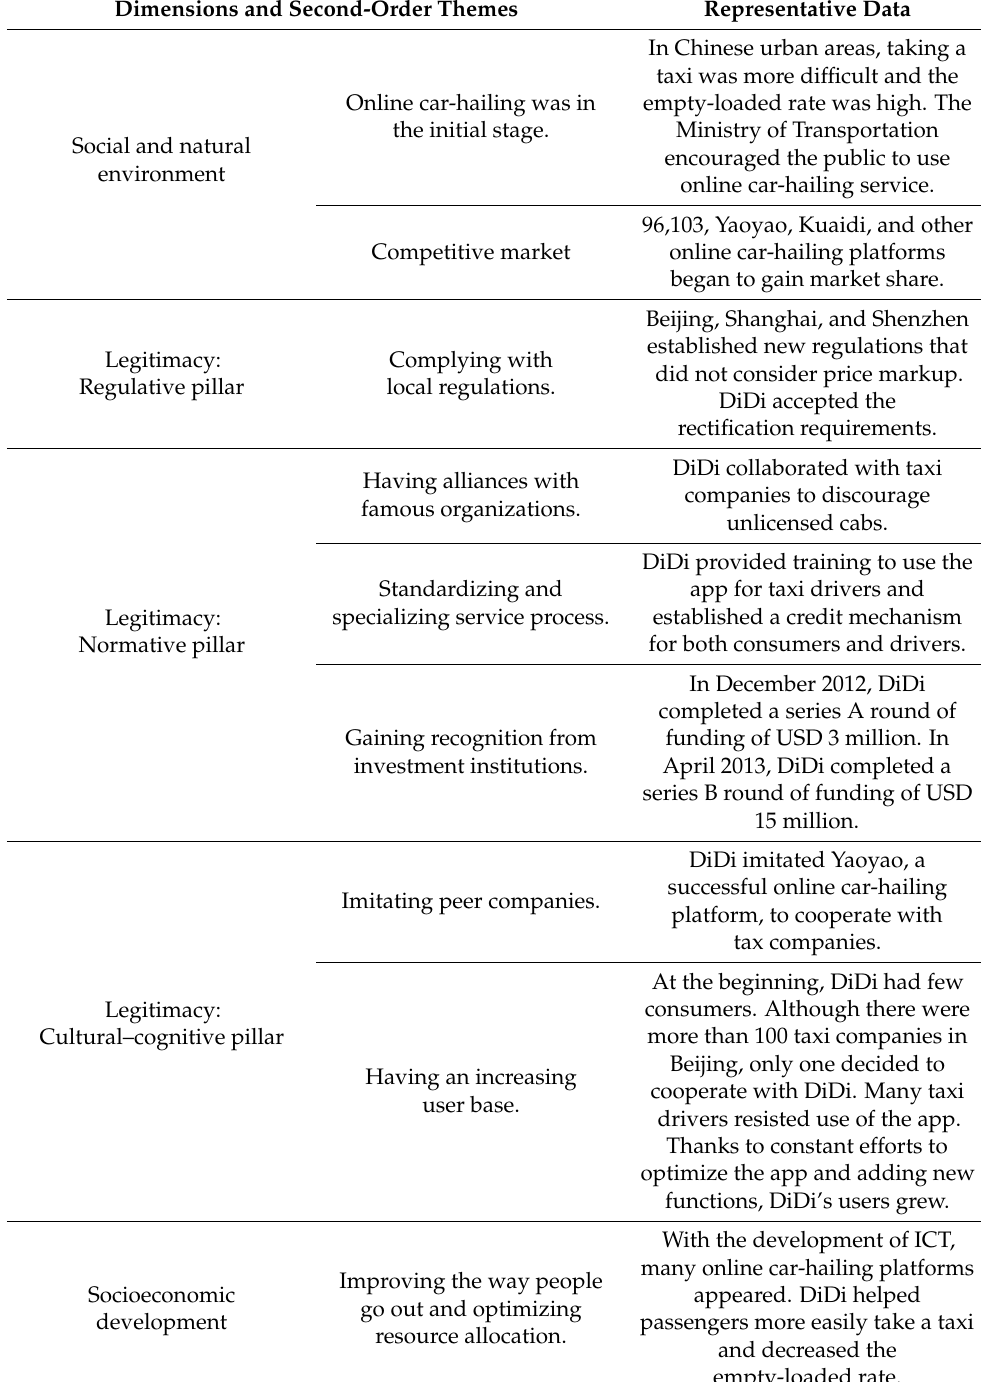
Table 3. Dimensions, themes, and data in the phase of looser regulatory requirements for